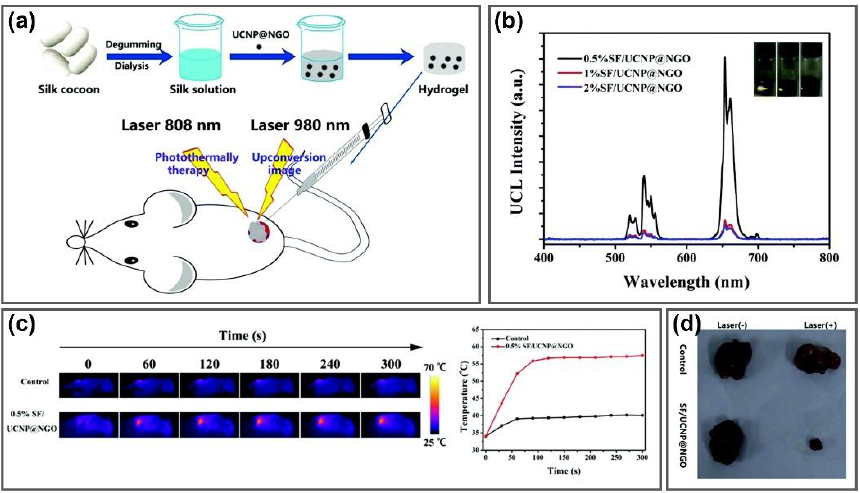
Figure 5. GGels for photothermal anticancer therapy. ( a ) Scheme of synthesis of SF/UCNP@NGO injectable silk fibroin nanofiber hydrogel hybrid system for synergistic upconversion luminescence imaging and PTT of breast cancer. ( b ) Upconversion luminescence spectra and digital pictures (inset) of SF/UCNP@NGO hydrogels at different SF concentrations under 980 nm laser irradiation. ( c ) In vivo photothermal imaging and temperature of tumors injected with PBS and 0.5% SF/UCNP@NGO hydrogels with 808 nm laser irradiation. ( d ) Mice tumors after photothermal treatment with SF/UCNP@NGO hydrogels. Adapted with permission from [110] .